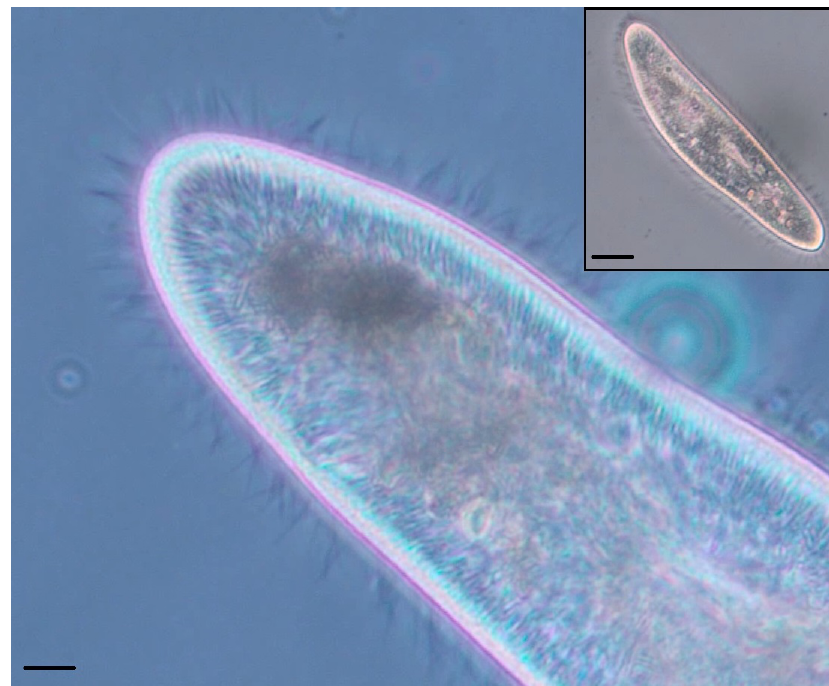
Figure 1. Phase contrast photomicrographs of a Paramecium caudatum . (Main) Anterior tip of the organism, showing hundreds of cilia (hair-like appendages) sprouting from its surface. Scale bar: 10 µ m. (Inset) Lower magnification view showing the whole organism. Scale bar: 25 µ